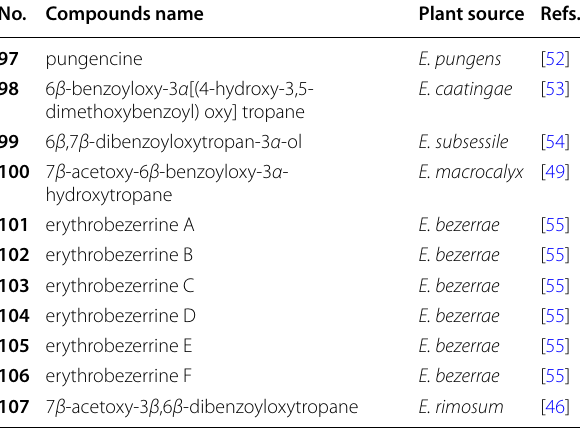
Table 6 Alkaloids isolated from Erythroxylum plants No. Compounds name Plant source